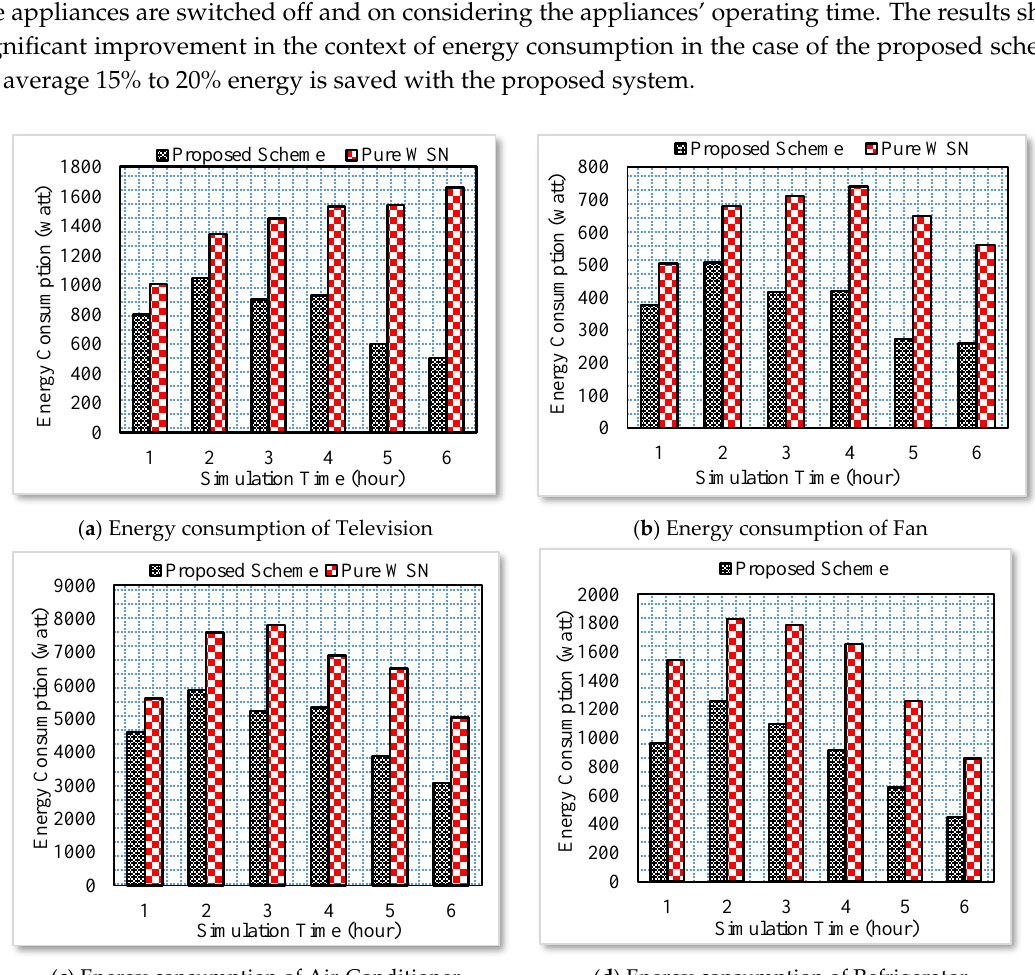
Figure 6. Energy consumption of various household appliances.